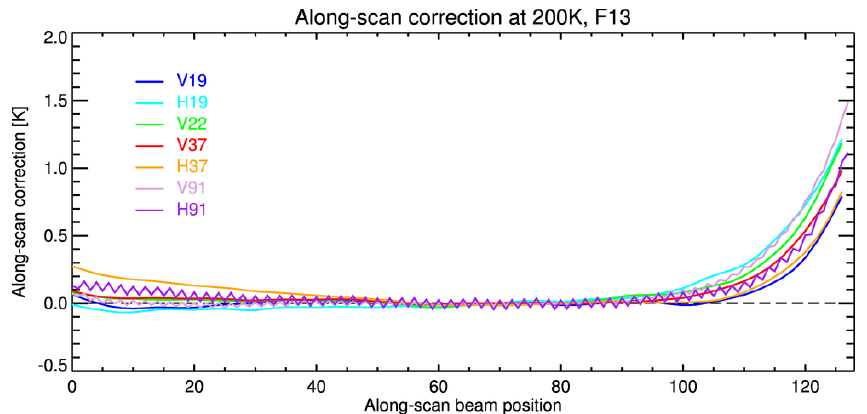
Figure 2. Along-scan correction for SSM/I F13 . The image shows the along-scan correction applied to a scene temperature of 200K. Colours are as follows: blue – v19; cyan – h19; green – v22; red – v37; orange – h37; plum – v85; violet – h85.